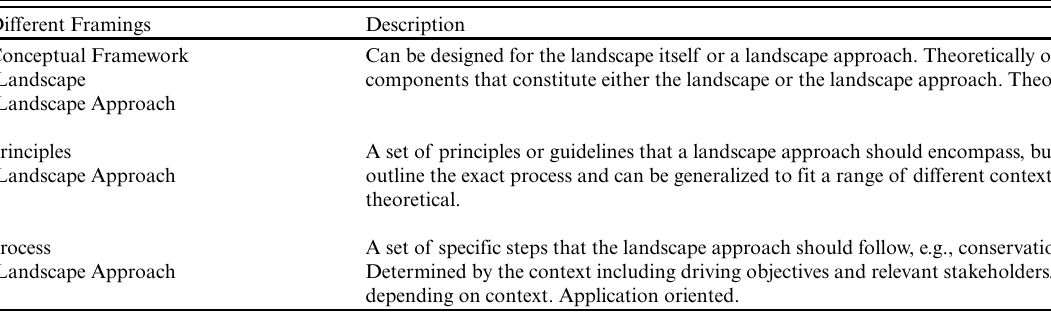
Table 2 . Three different framings of landscapes/landscape approaches in the